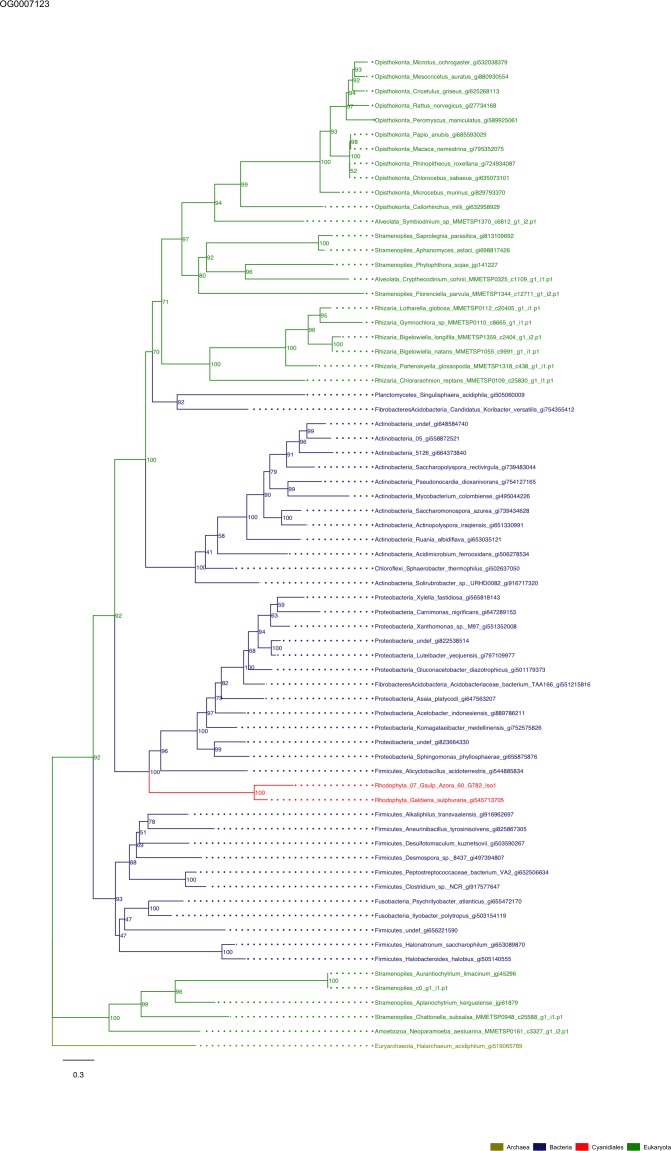
Sequence tree of orthogroup OG0007123.The tree is based on amino acid sequences. Archaea (yellow), Bacteria (blue), Cyanidiales (red), Eukaryotes including other red algae (green). Branches containing Cyanidiales sequences are highlited in red.